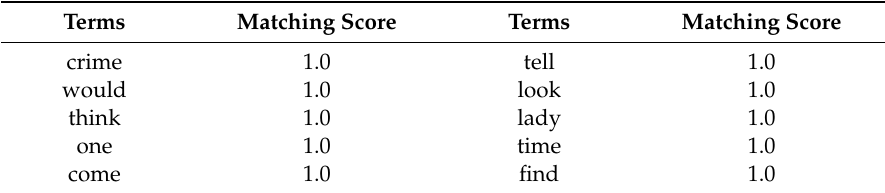
Table A1. Top terms for term crime.